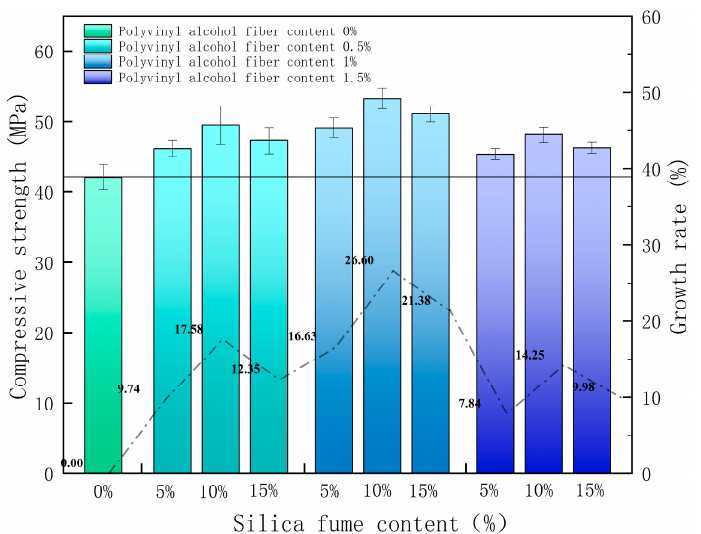
Figure 3. Compressive-strength growth of the SPRC.